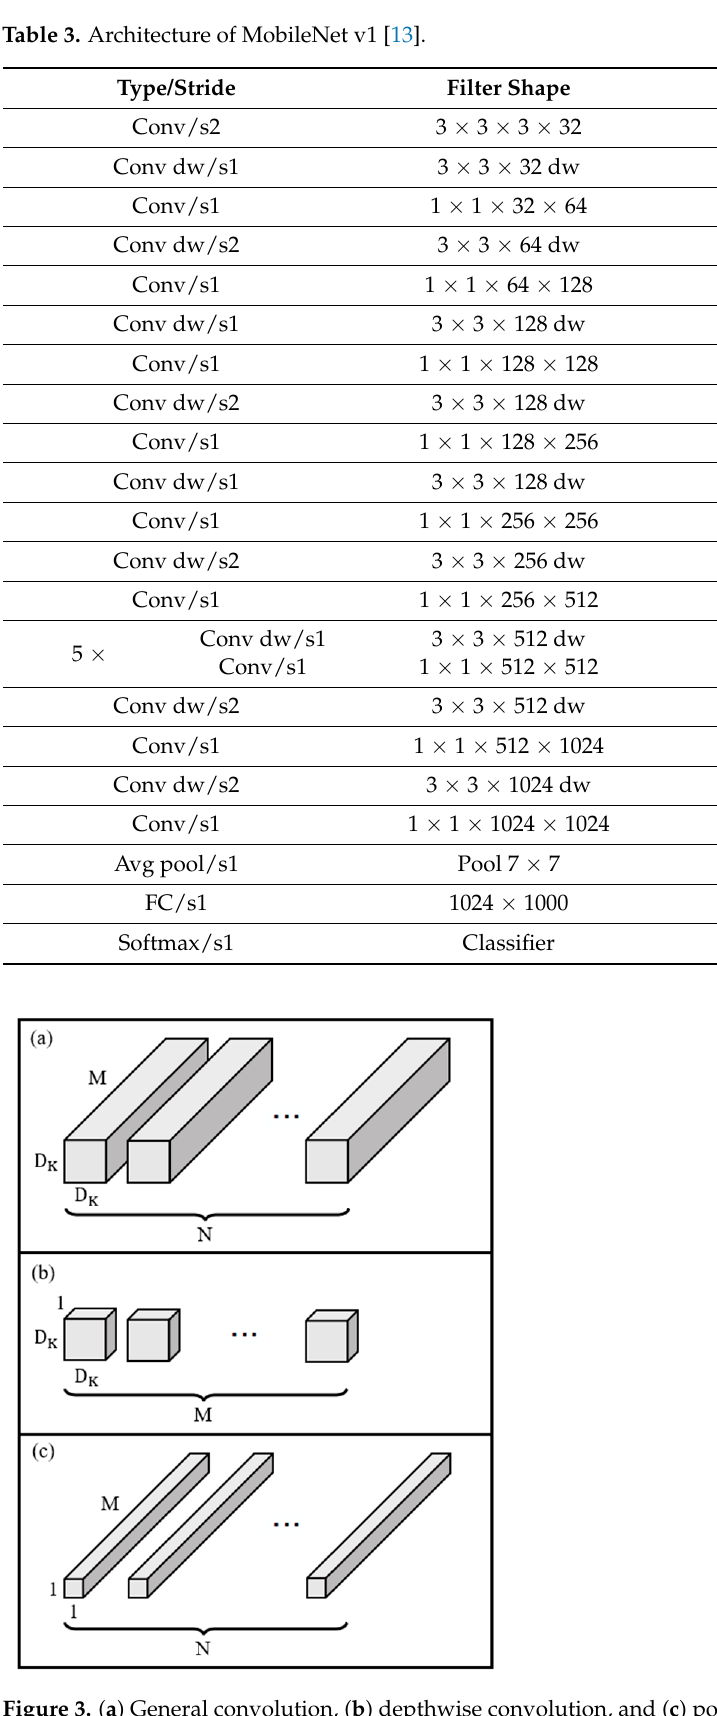
Figure 3. ( a ) General convolution, ( b ) depthwise convolution, and ( c ) pointwise convolution [13].